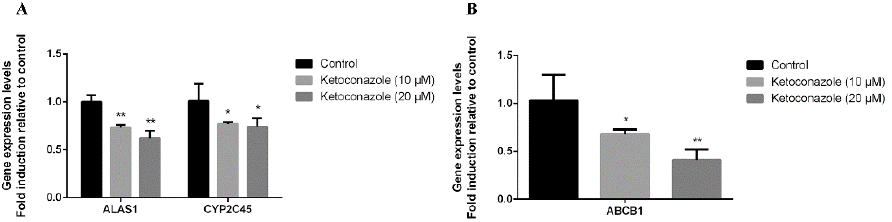
Figure 2. Effects of the CXR antagonist ketoconazole on P-gp expression in chicken primary hepato- cytes. Cells were exposed to ketoconazole with or without the CXR agonist metyrapone for 24 h. RT-PCR analysis of ALAS1, CYP2C45 ( A ) and ABCB1 ( B ) mRNA levels. Bars show means ± SD of at least three independent experiments. * p < 0.05, compared with the control group; ** p < 0.01, compared with the control group.